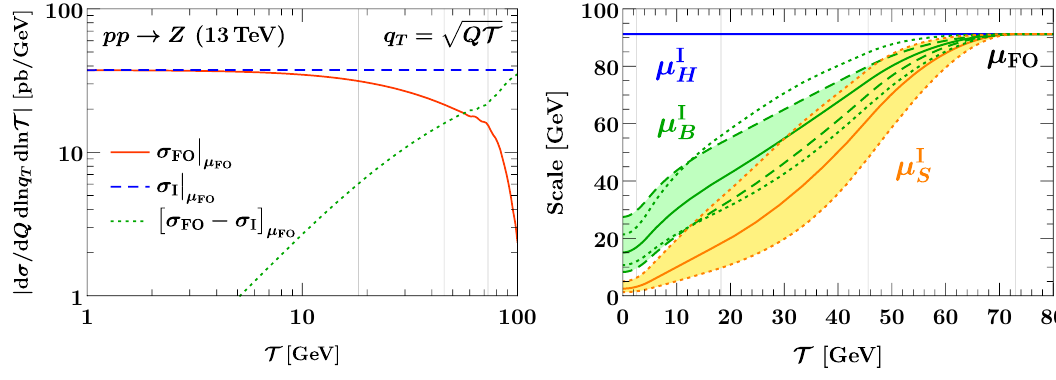
Figure 3 . Left: comparison of singular and nonsingular contributions to the (cid:12)xed O ( (cid:11) s ) double p spectrum as a function of T , with q T = Q T kept (cid:12)xed. The orange solid line shows the full QCD result and the dashed blue line the singular contributions contained in the SCET I result eq. (2.6). The dotted green line shows their di(cid:11)erence, which corresponds to the power corrections indicated in eq. (2.7). Right: SCET I pro(cid:12)le scales and their associated variations. The dotted lines (and the yellow band) indicate common up/down variations of (cid:22) I and (cid:22) I from varying (cid:11) . The dashed lines S B (and the green band) are variations of (cid:12) that only act on (cid:22) I . In both plots, the thin vertical lines B correspond to the transition points ( x 0 ; x 1 ; x 2 ; x 3 ) given in the